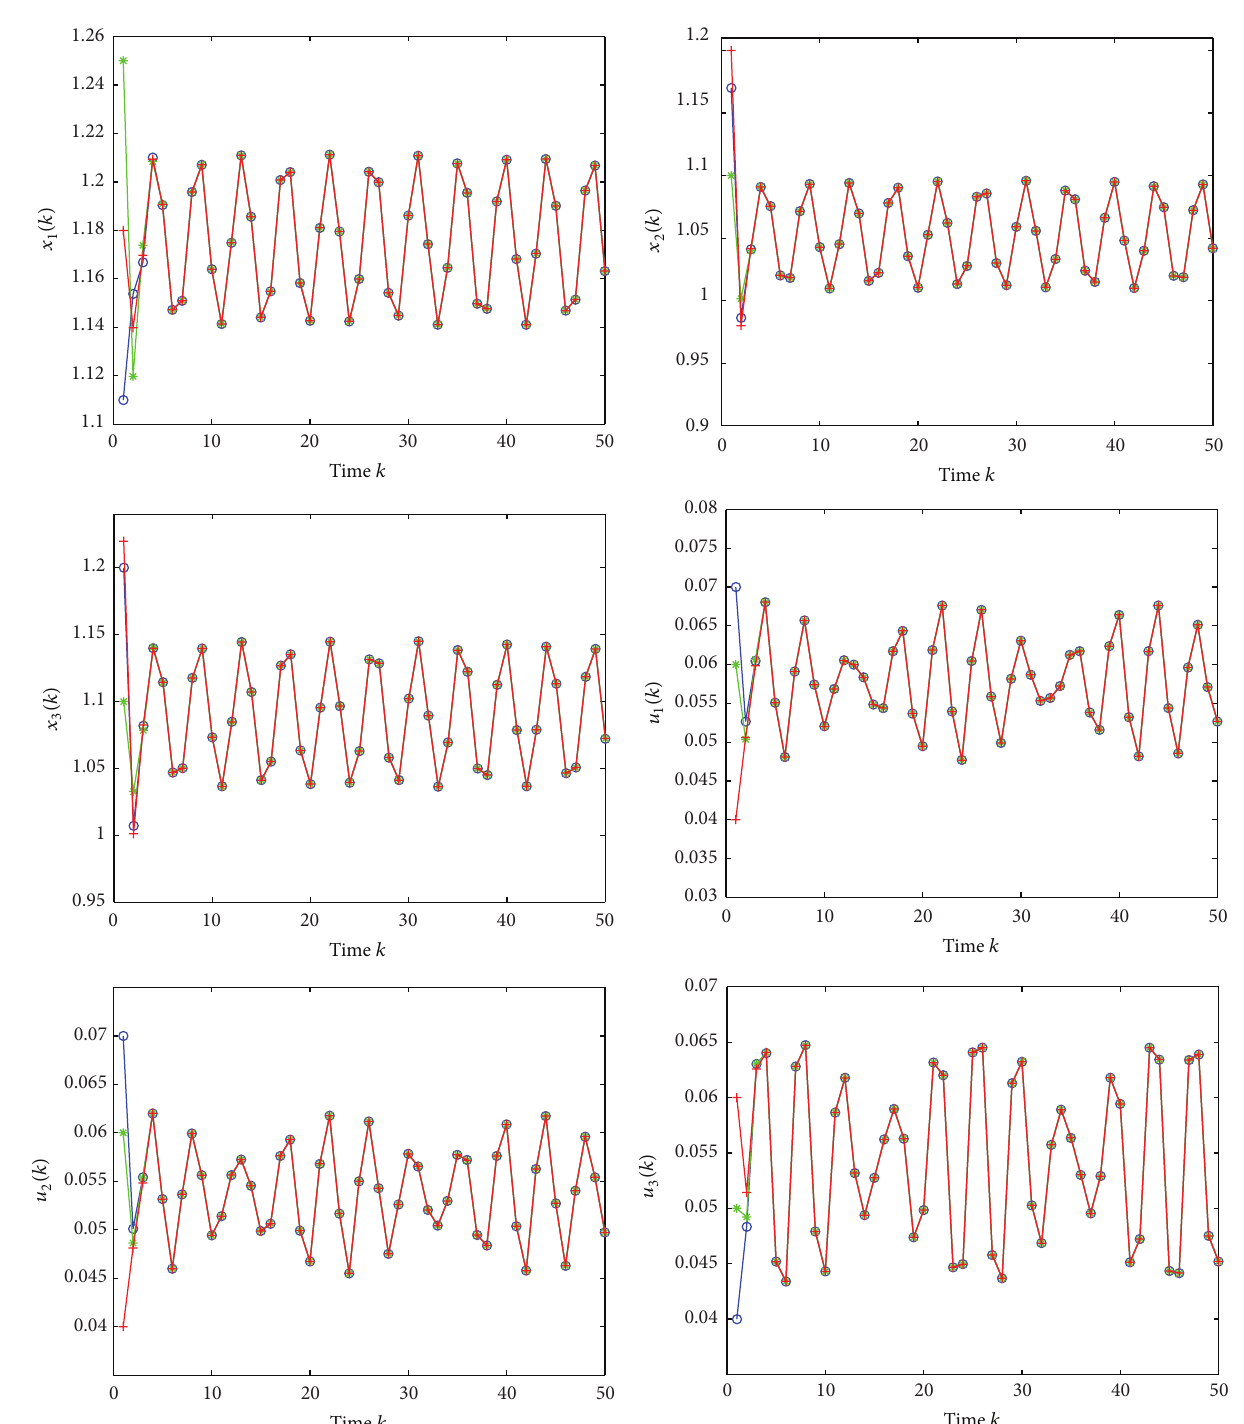
Figure 1: Dynamic behavior of positive almost periodic solution (𝑥 1 (𝑘),𝑥 2 (𝑘),𝑥 3 (𝑘),𝑢 1 (𝑘),𝑢 2 (𝑘),𝑢 3 (𝑘)) of system (60) with the three initial conditions (1.11, 1.17, 1.2, 0.07, 0.07, 0.04) , (1.25, 1.1, 1.1, 0.06, 0.06, 0.05) , and (1.18, 1.2, 1.22, 0.04, 0.04, 0.06) for 𝑘 ∈ [1, 50] ,